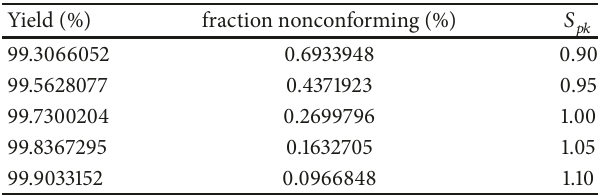
Table 1: The process yield, process fraction nonconforming, and corresponding value of the process yield index 𝑆 𝑝𝑘